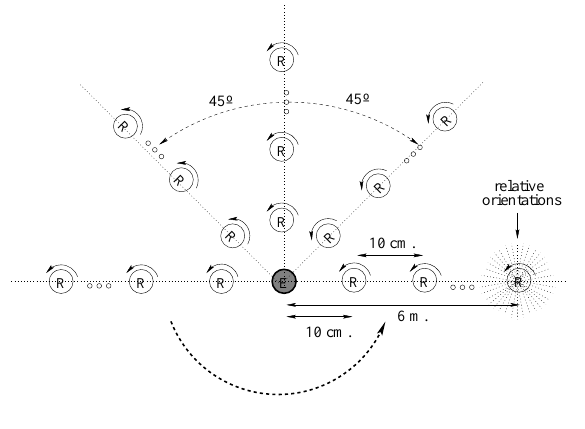
Figure 15. Algorithm performance for calculating (a) the angle and (b) the distance error. Each box comprises observations ranging from the first to the third quartile. The median is indicated by a horizontal bar, dividing the box into the upper and lower part. The whiskers extend to the farthest data points that are within 1.5 times the interquartile range. Outliers are shown as